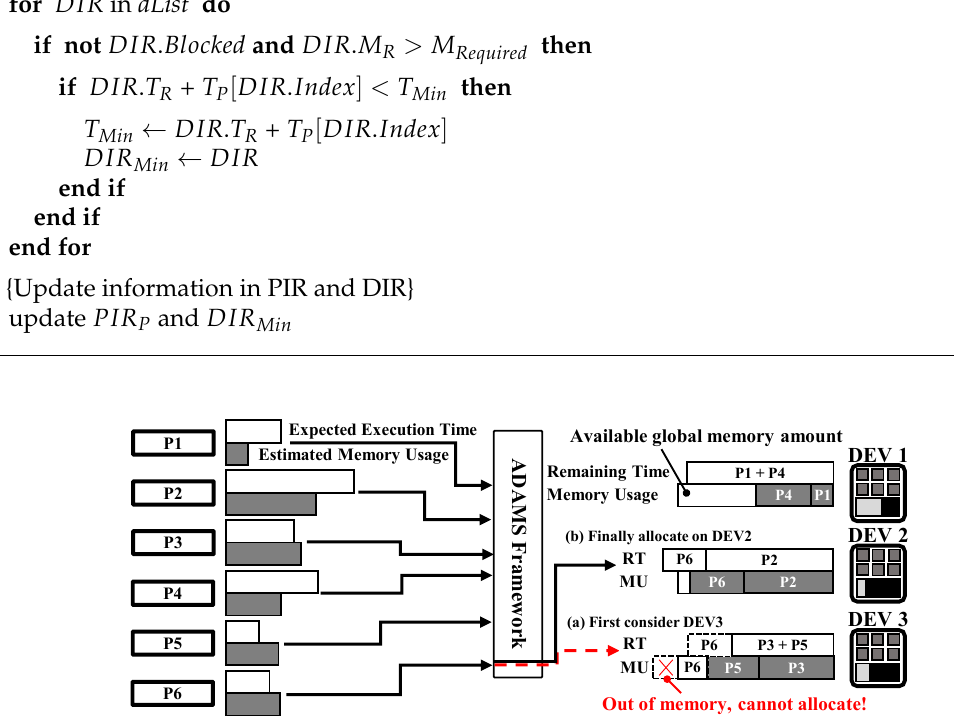
Figure 6. A simplified ADAMS workflow and a process allocation example. ( a ) a rejected attempt to assign P6 to DEV 3, and ( b ) a final assignment of P6 on